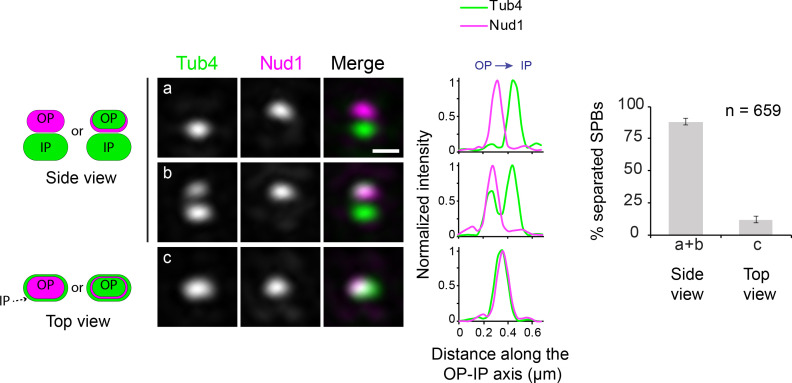
Discrimination between SPB side and top view in SIM images.SIM images of wild type cells expressing Tub4-Venus and Nud1-mT2 were used to score the overall proportion of individual SPBs presented in side view (a-b) and top view (c). Note that the use of Nud1, a core component of the SPB outer plaque, further confirms the side view in SPBs lacking Tub4 outer plaque marking (b). Error bars, standard error of the proportion. Scale bar, 200 nm.